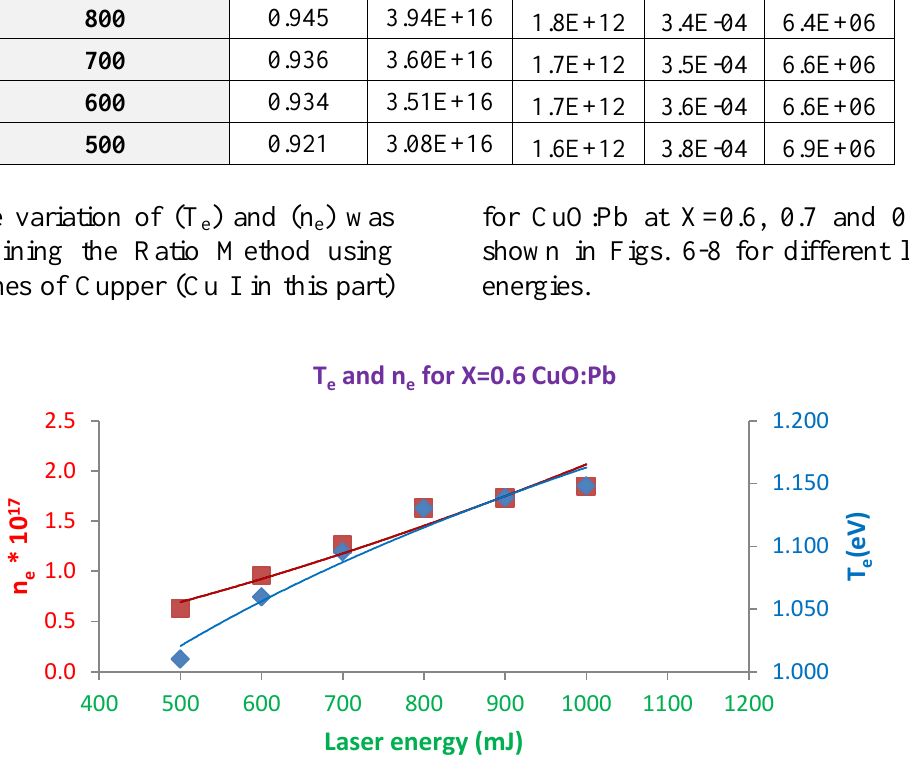
) versus the laser energy for CuO:Pb at X=0.7 in e